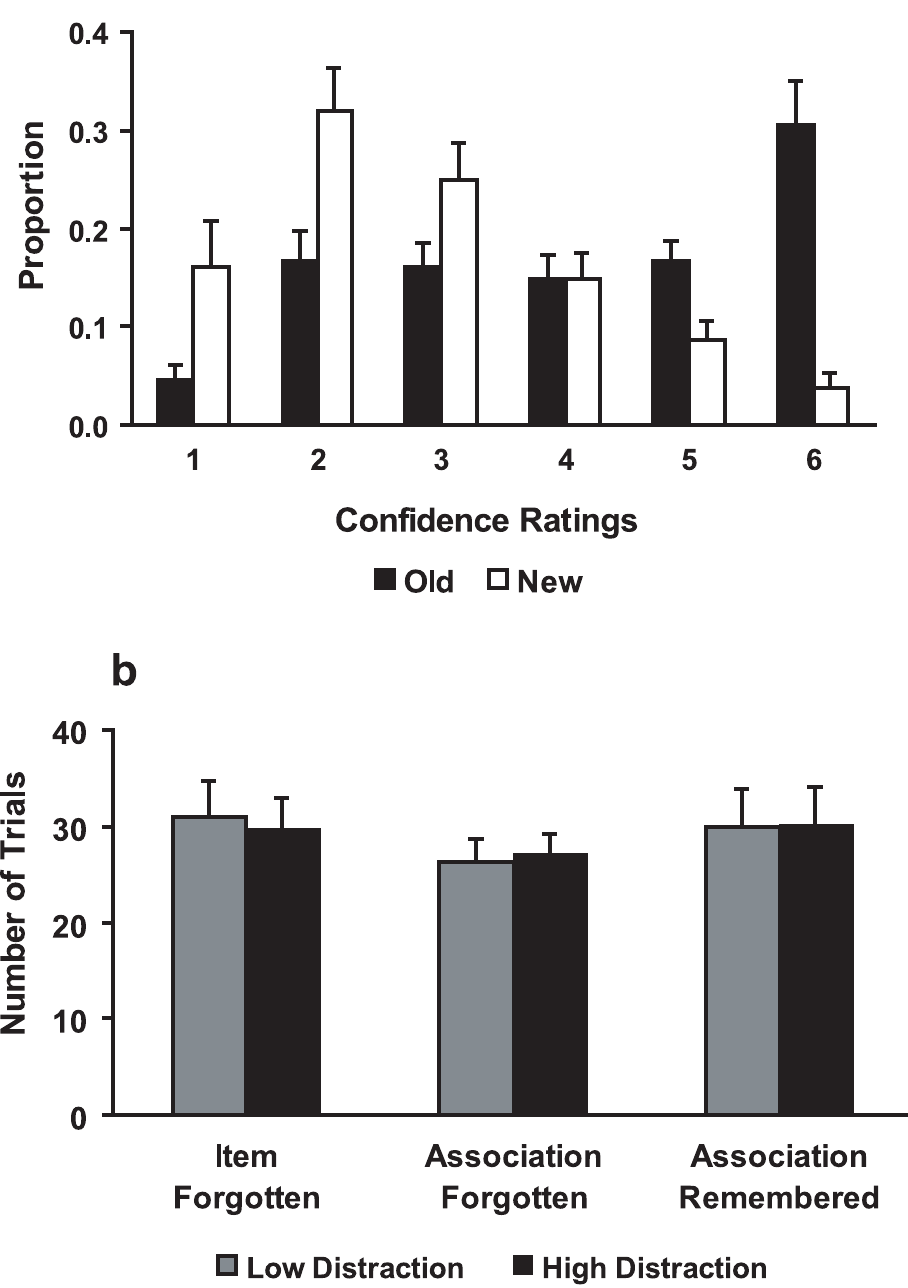
Figure 2. Behavioral performance. a , Behavioral results of the face recognition memory test. Confidence ratings range from ‘1’ (absolutely sure that the face is new) to ‘6’ (absolutely sure that the face is old, i.e. has been studied during the encoding session). There were significant differences for old and new faces in all ratings except for rating ‘4’. b , Subsequent memory performance based on the memory status (Item forgotten, Association forgotten, Association remembered) and the distraction condition (low and high distraction). There were no differences in performance between the different levels of distraction or memory status. Error bars represent SEM.